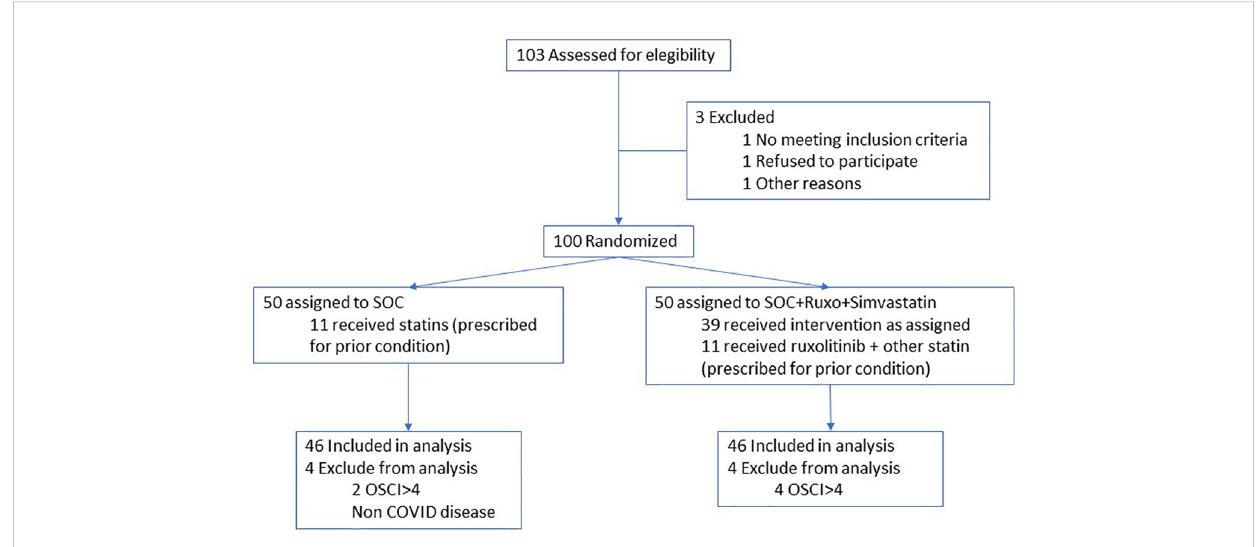
FIGURE 1 Flow chart of patient